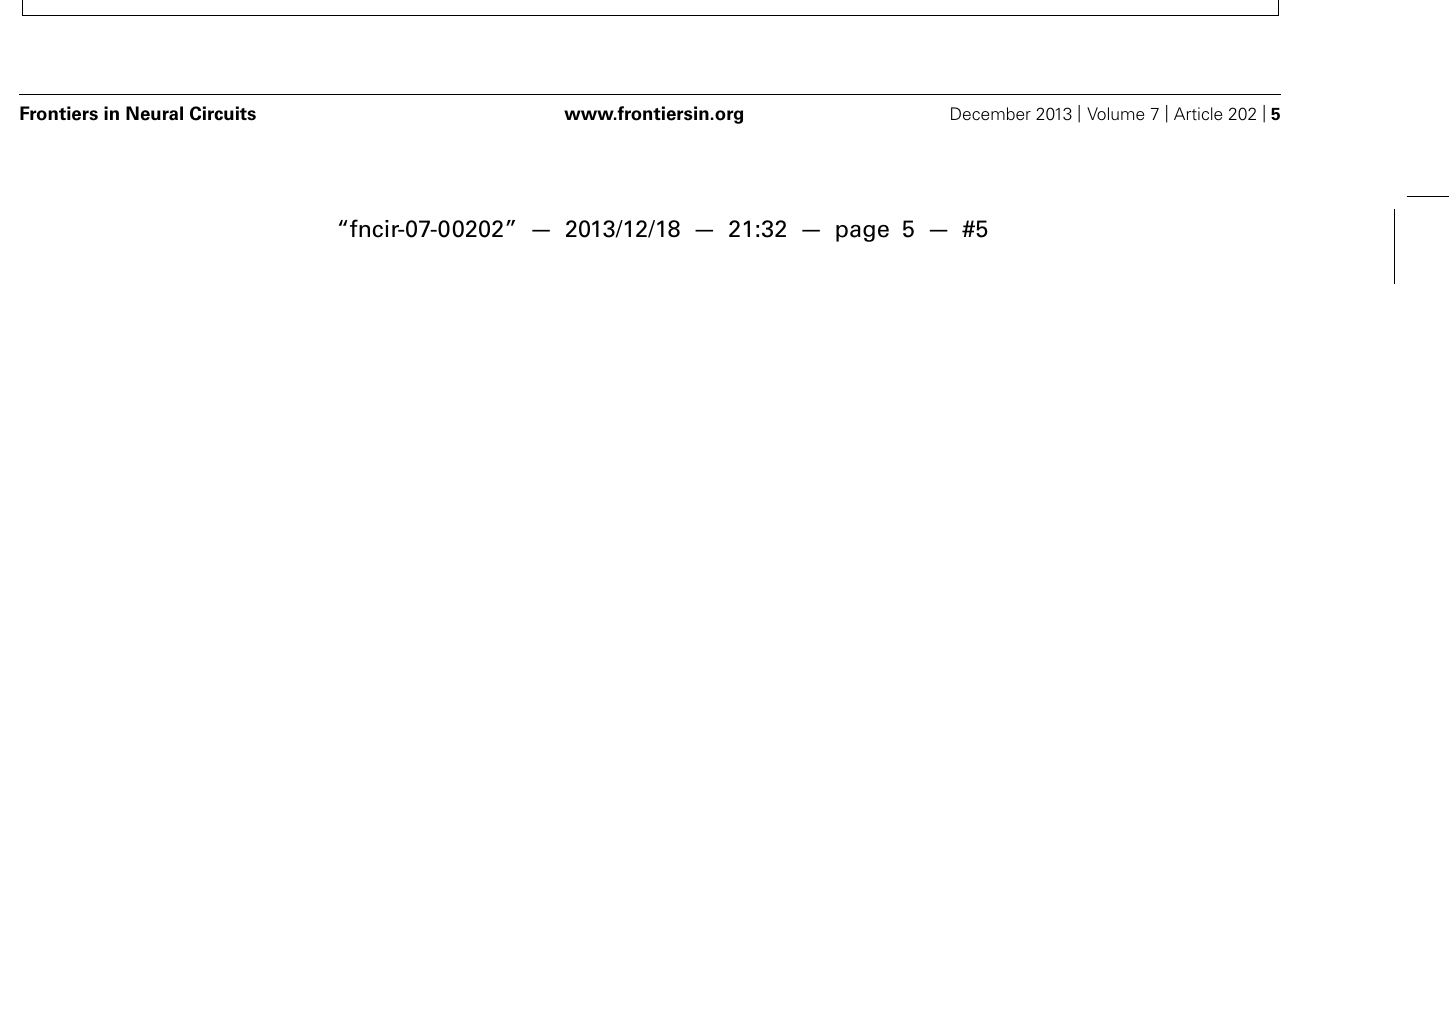
treatment and Fc controls. The error bars represent SEM. *** P < 0.001. (D) Reverse transcriptase PCS product from thalamic explants in co-cultures. The ∼ 170 bp PCR product suggests that thalamic cells produce TrkB. (E) BDNF tagged with Cy3 was molded in strips of agar and applied to the neocortical explant (hatched region) in thalamocortical co-cultures. (F) Neurons in the thalamic explants contained Cy3-BDNF 5 days later. Fluorescence micrograph from the boxed region in